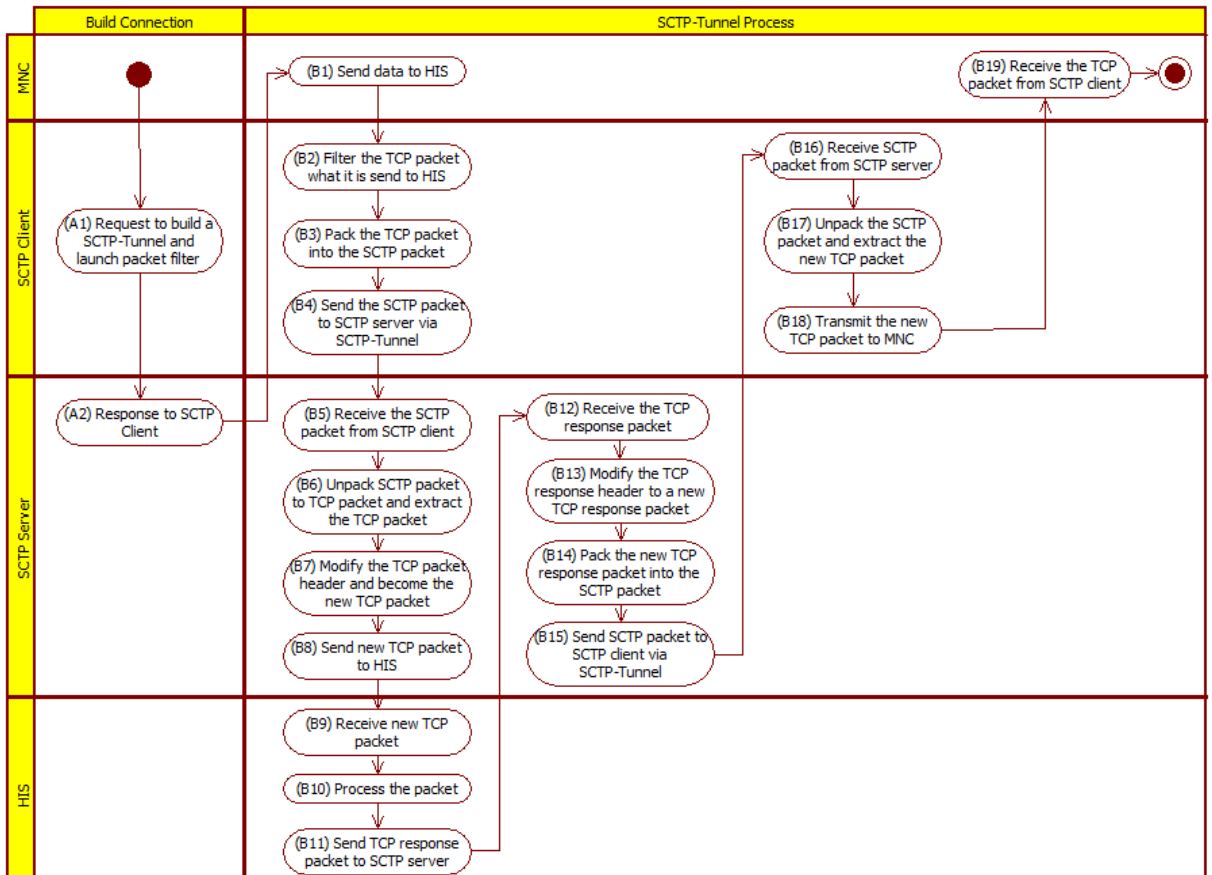
Figure 2. Activity diagram for the SCTP-Tunnel